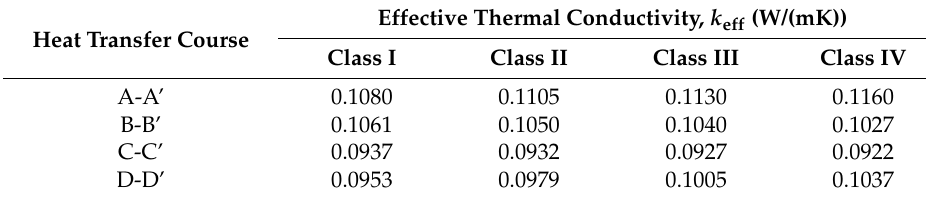
. q (cid:48)(cid:48) = 50 kW/m 2 . irr